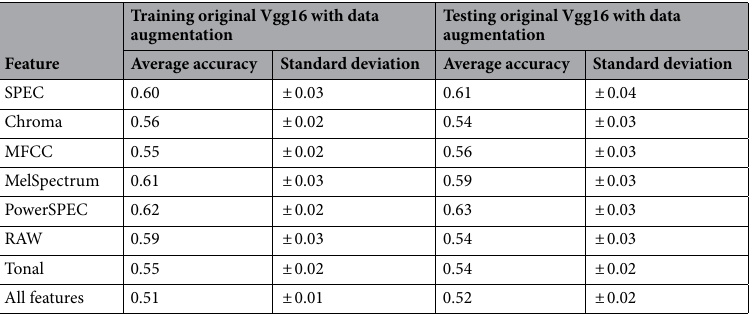
Table 8. Average classification performance for the training and testing of the original Vgg16 network with data augmentation over 100 training epochs.